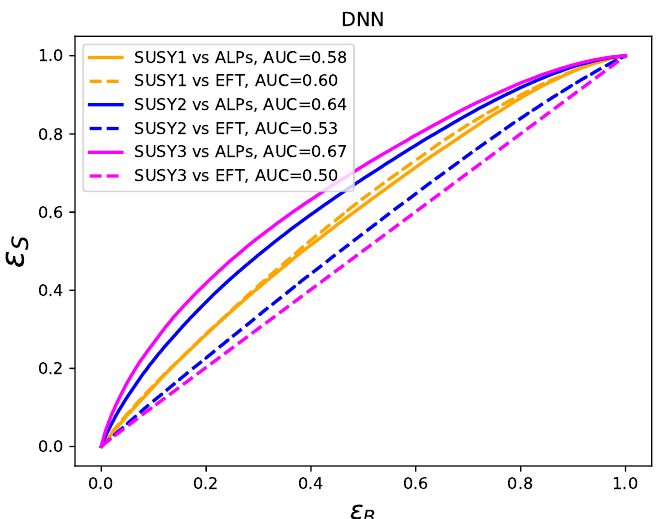
Figure 5: ROC curves using Neural Network for different WIMP scenarios versus ALP / EFT signals using the raw kinematic features (monojet